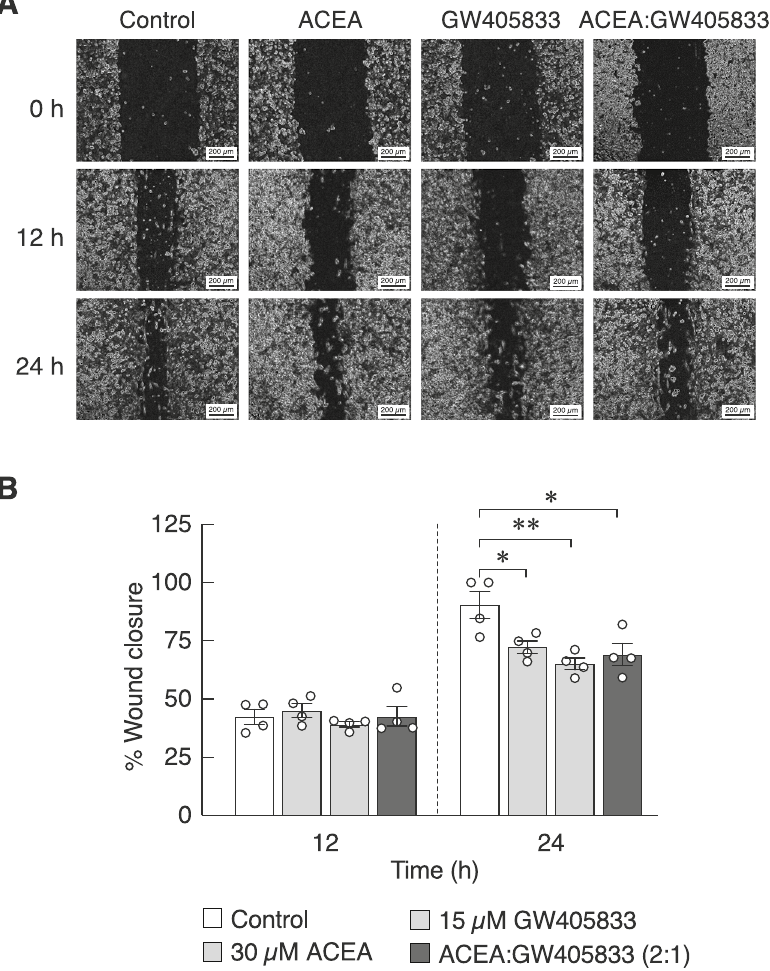
Figure 8. Combining effect of ACEA and GW405833 at ratio of 2:1 on MDA-MB-231 cell migration. ( a ) Representative images illustrated the migration of MDA-MB-231 cells treated with the indicated concentrations of each compound or the combination for 12 and 24 h. Cell migration was assessed by wound healing assay. ( b ) Quantified data is represented as mean ± SEM of two independent biological experiments with two technical duplicates each. (** p < 0.01, * p <